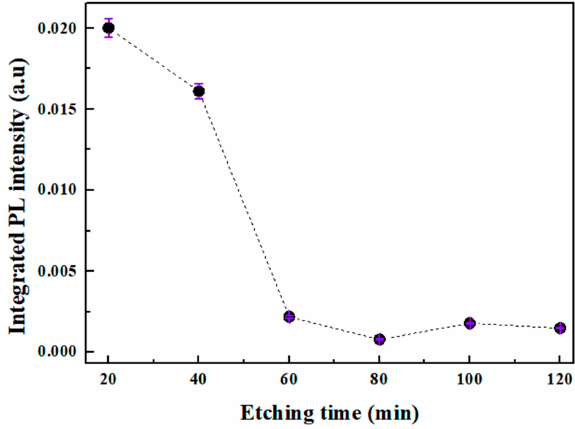
Figure 7. Variation of integrated PL intensities versus etching duration.